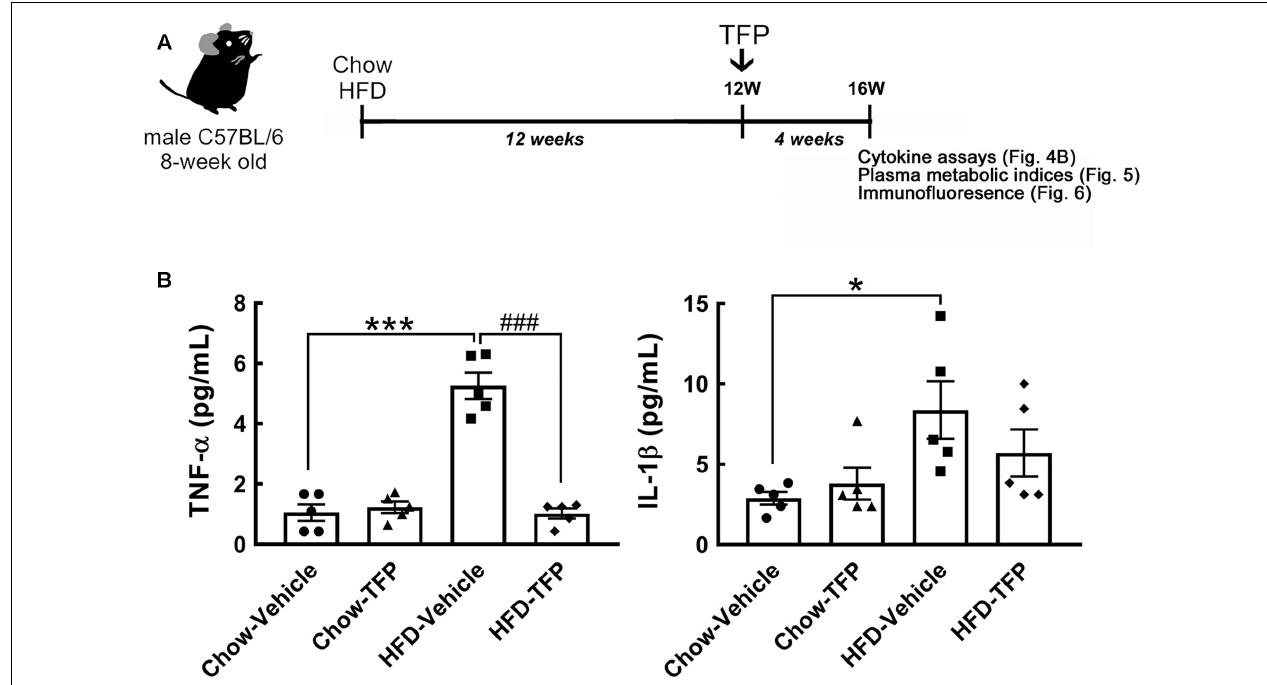
FIGURE 4 | Decreased levels of plasma TNF- α and IL-1 β in obese mice treated with TFP for 4 weeks. (A) The schematic illustration shows that 8-week-old male C57BL/6 mice were fed chow or HFD for 12 weeks and then injected daily with TFP (2 mg/kg) via the i.p. route for another 4 weeks under Chow or HFD feeding (Chow-Vehicle, Chow-TFP, HFD-Vehicle, HFD-TFP). At 16 weeks post feeding, blood samples were collected from animals without fasting for cytokine assays (B) and with fasting for the analysis of metabolic indices ( Figure 5 ). The brains were removed for sectioning and immunostaining ( Figure 6 ). (B) As indicated above, the plasma samples were subjected to TNF- α or IL-1 β ELISA. Data are presented as the mean ± SEM ( n = 5 animals for each group). Each dot represents one animal. * p < 0.05, *** p < 0.001 vs. Chow-Vehicle; ### p < 0.001 vs.